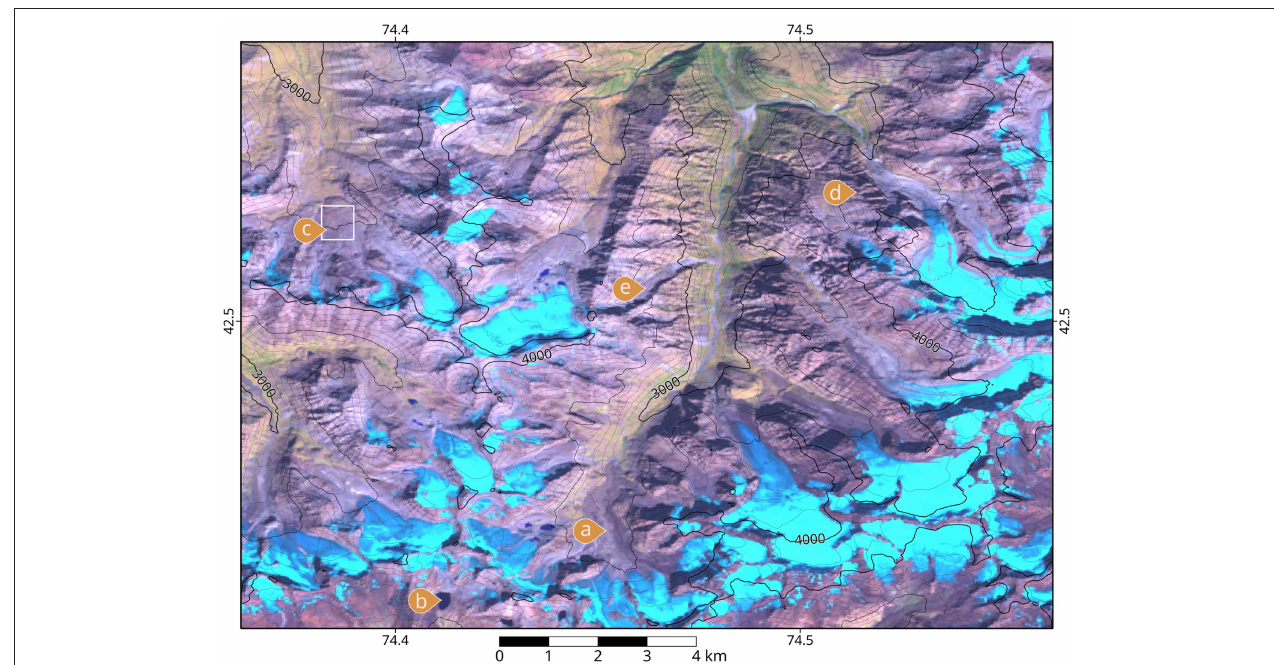
FIGURE 2 | Core study area in the Ala Archa region of the Kyrgyz Range in optical imagery (Landsat 8, 2017-09-16, bands 6-5-4) with contours from SRTM. Arrows indicate features of particular interest, e.g., (a) proglacial areas framed by Little Ice Age moraines, (b) proglacial lakes, (c) rock glaciers, (d) steep slopes in permafrost areas, and (e) gullies. The white rectangle outlines the area investigated in the rock glacier coherence time series (cf. section